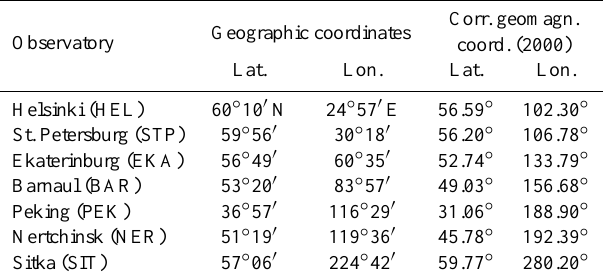
Table 1. Geomagnetic observatories in Finland (Helsinki) and Rus- sia used in this